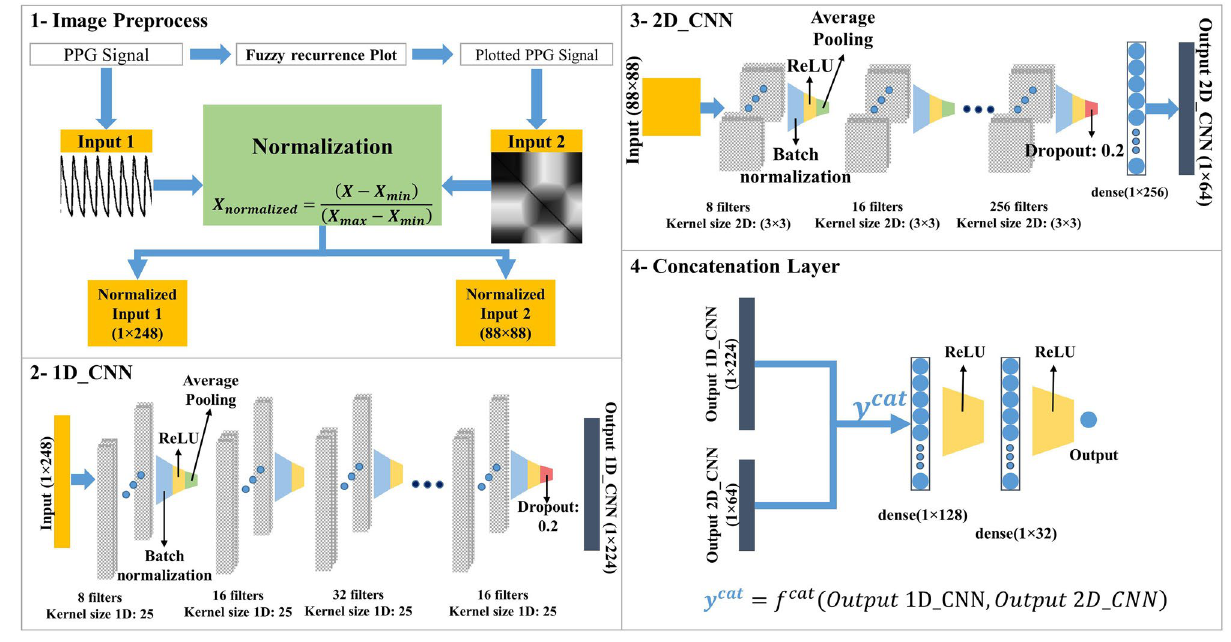
Figure 5. The proposed Concat_CNN